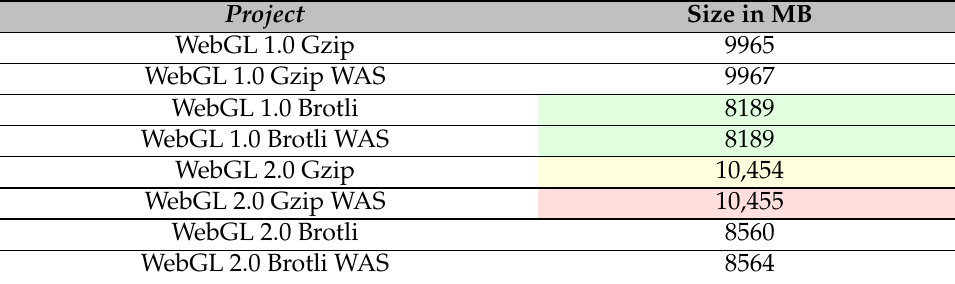
Table 4. Size of the exported